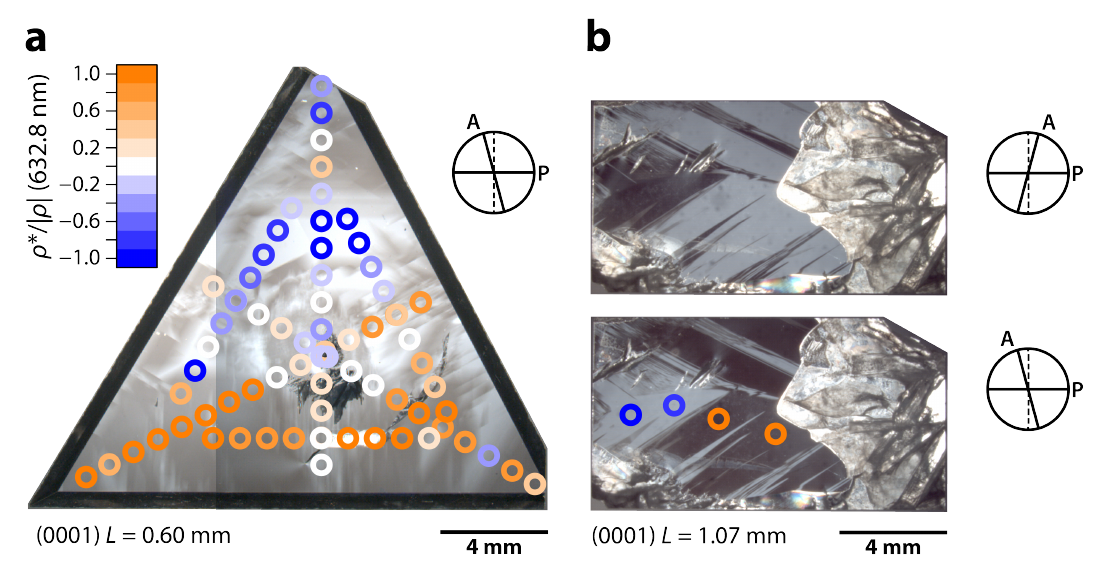
Figure 5. ( a ) YAB and ( b ) KABO crystals cut perpendicular to the c axis. The crystal sections are viewed between slightly decrossed polarizers as schematically indicated by the diagrams showing the relative orientations of the polarizer (P) and analyzer (A) for each image. Note the congruence of domains that are in extinction positions in the upper panel of ( b ) and appear bright in the lower panel and vice versa. The colored rings give the positions for measurements of the apparent rotatory power. The size of the symbols reflects the approximate diameter of the laser beam. Rings are colored according to the relative apparent rotatory power at a wavelength of 632.8 nm, as indicated by the color scale in ( a ). Note the correlation between the extinction behavior and the sign of the apparent rotatory